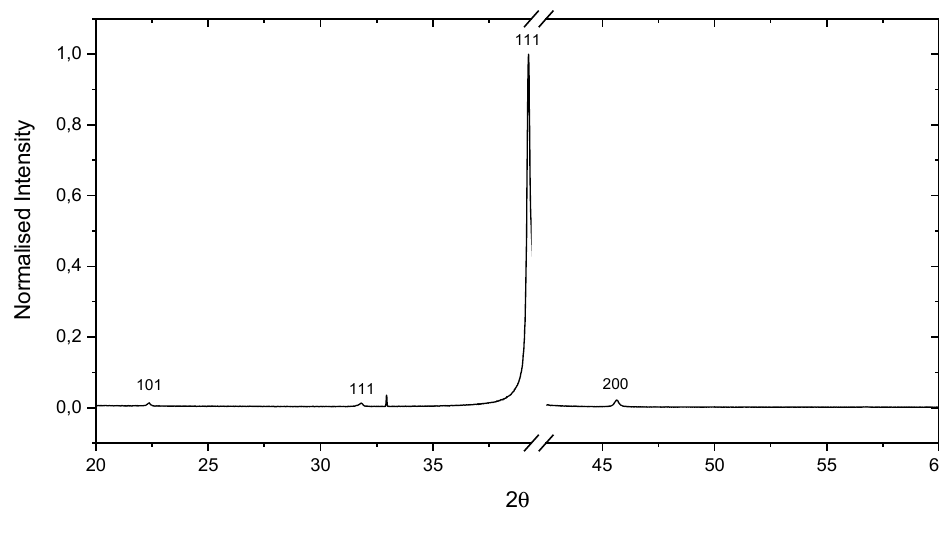
Figure 3. XRD pattern of Ba 0.6 Sr 0.4 TiO 3 thin film annealed at 800 °C. Substrate peaks have been